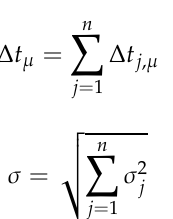
Table 1. Time values for working cycle operations.